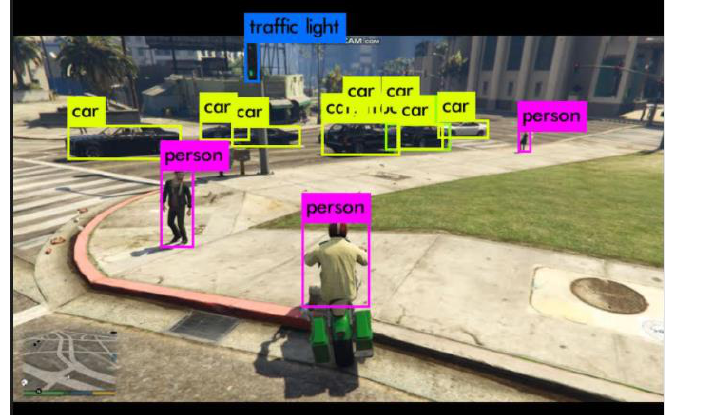
Figure 4. Object detection